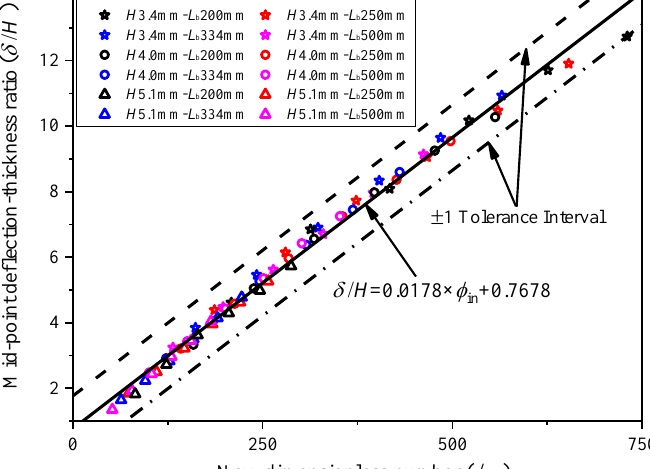
Figure 9. The midpoint deflection–thickness ratio versus the new dimensionless number